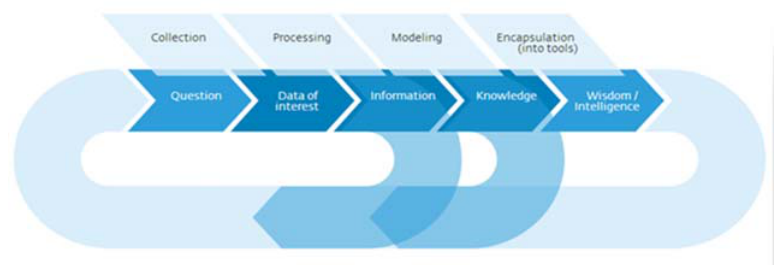
Figure 1. The circular nature of hydroinformatics .